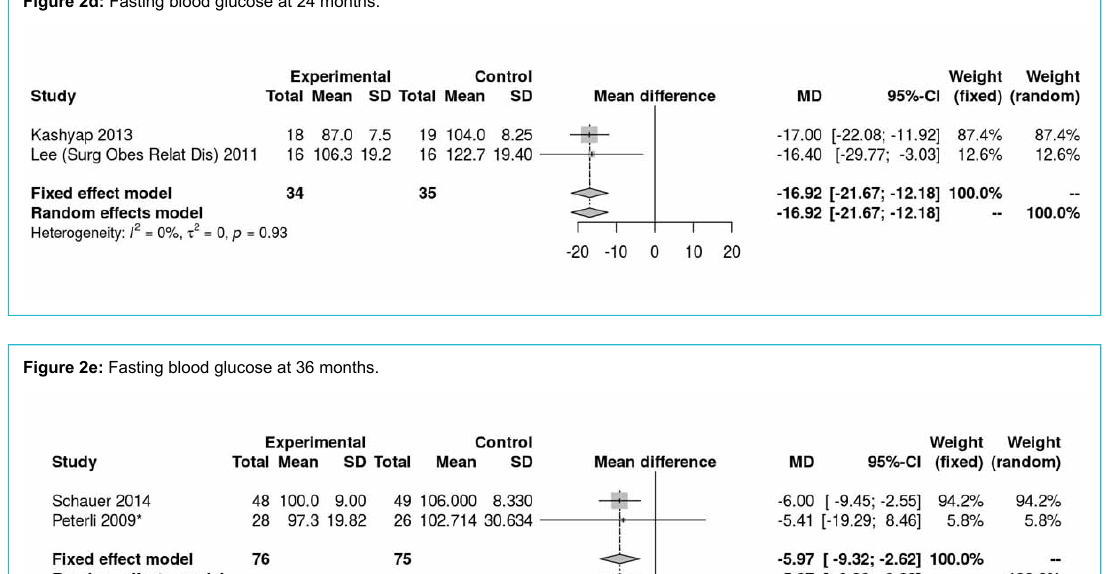
Figure 2d: Fasting blood glucose at 24 months.